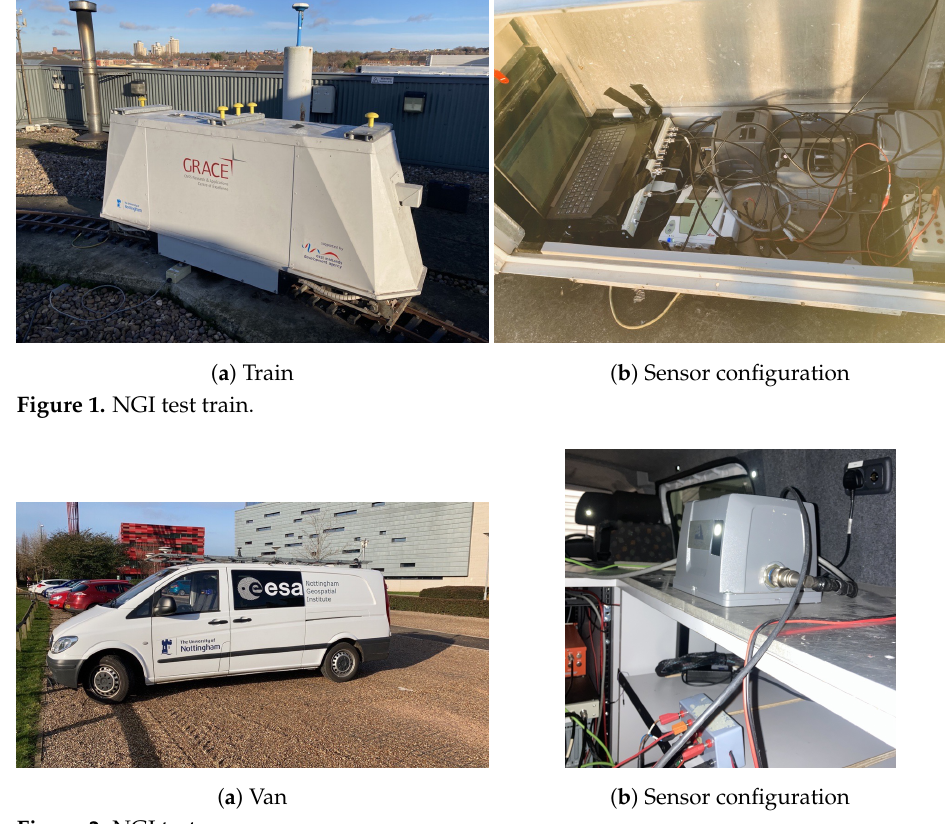
( b ) City center test Figure 3. Trajectories of two van positioning tests. Table 1. Sensor sampling rates, lever arm, and installation angles from the two tests. Train Test